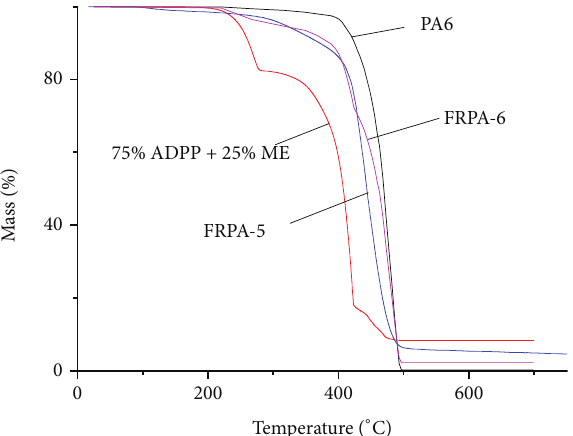
Figure 7: TG of the flame-retarded PA6 with ADPP/ME. FRPA-5: flame-retarded PA6 with 25 wt% of 75% ADPP/25% ME; FRPA-6: additive curve of PA6 and ADPP/ME.